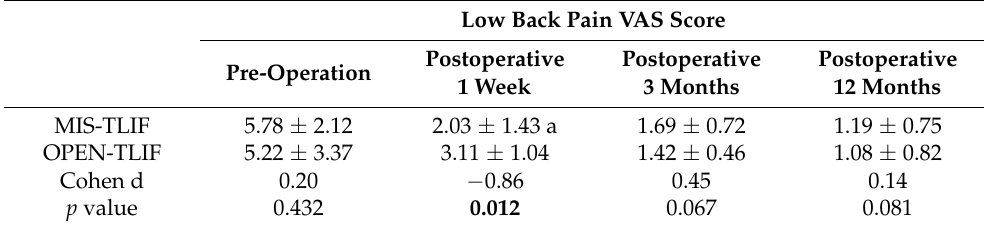
Table 3. Changes in low back pain VAS score during the follow-up.